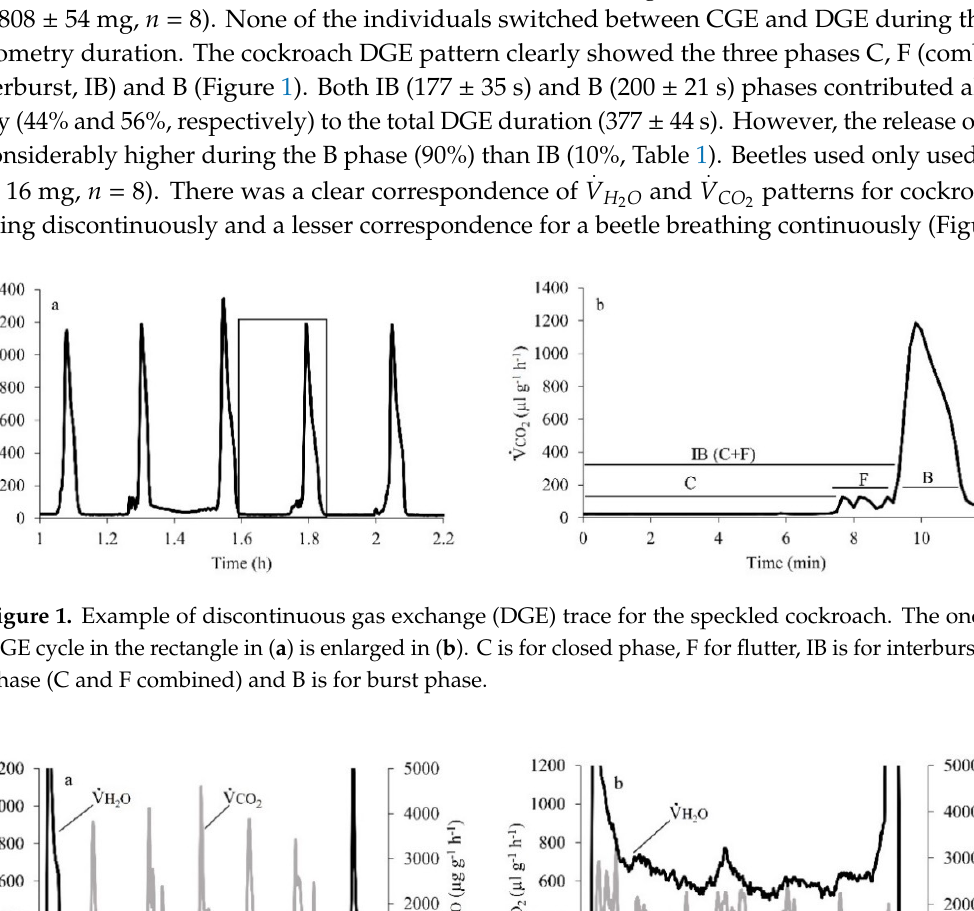
. ( μ g g − 1 h − 1 ), V H ( µ g g − 1 h − 1 ), ( μ g g − 1 h − 1 ), (cid:3118) (cid:3016) 2 O (cid:3118) (cid:3016)